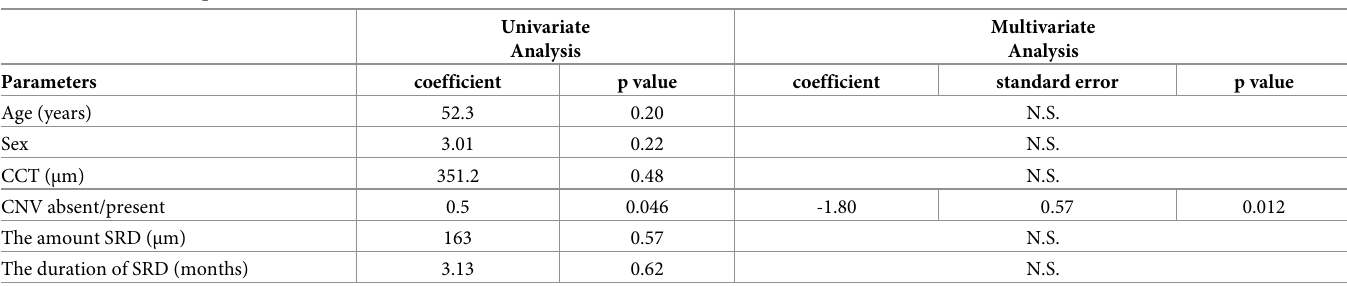
Table 3. Results of the optical model selection for ⊿